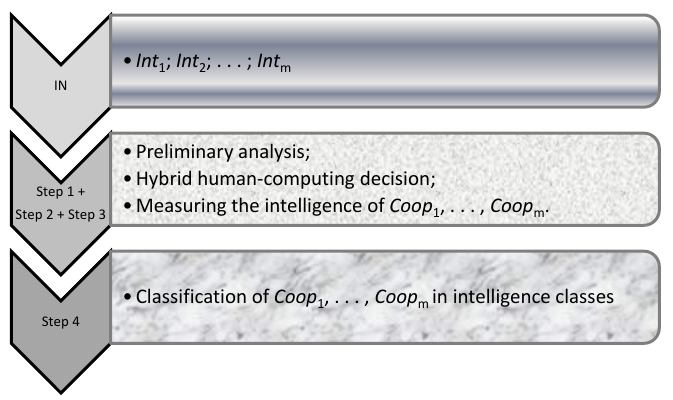
Figure 1. Main processing performed by the Algorithm 1.